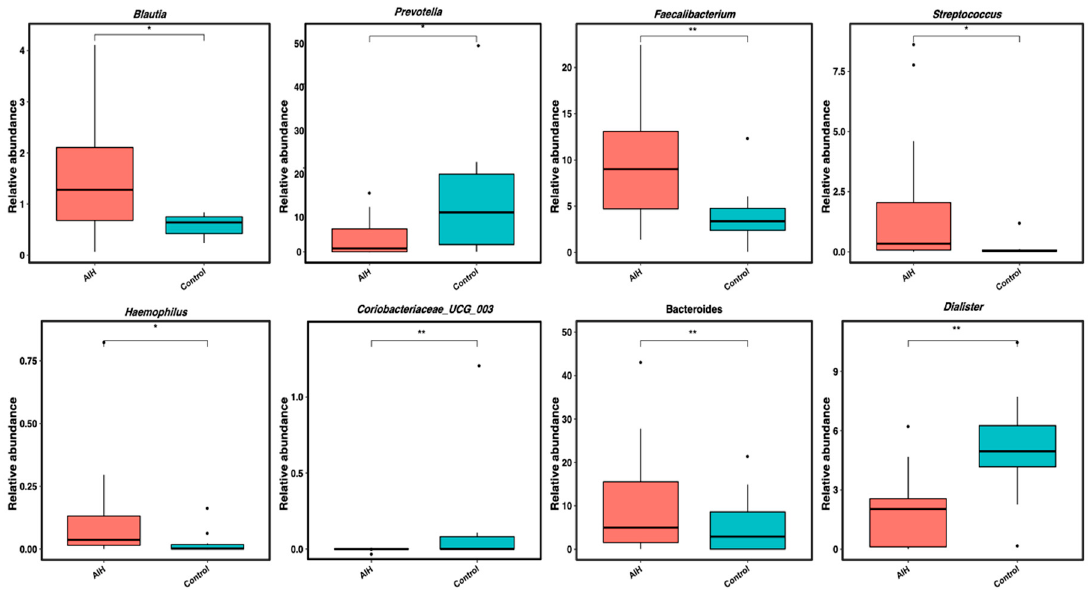
Figure 3. Genera that significantly differed between the studied groups. Box plots display the dominant genera that were detected with significant differences in abundance between studied age groups. Asterisks denote significant differences (ns, p > 1; * p < 0.05; ** p < 0.01). Table 2. The core and the shared genera in the entire dataset.